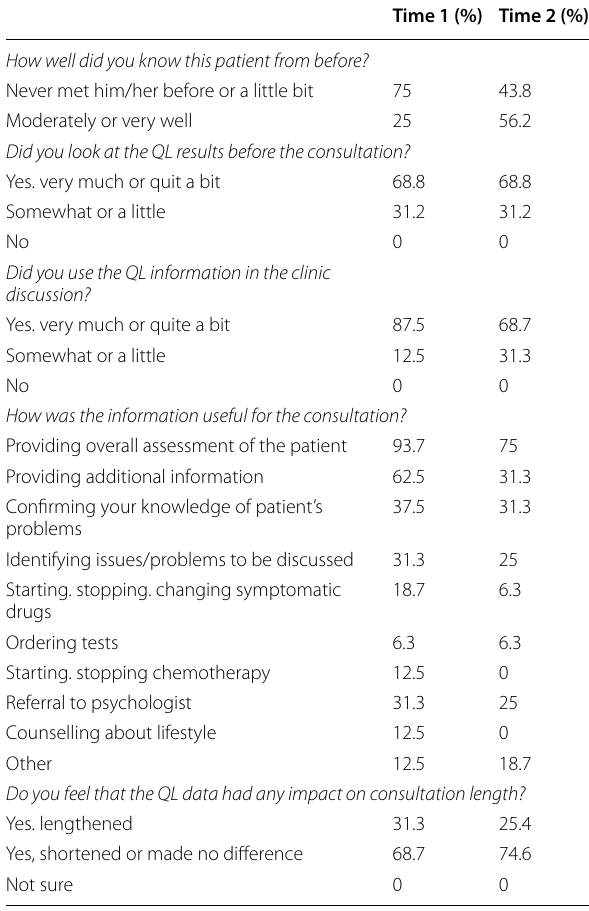
Table 2 Oncologists’ responses to the VSD1